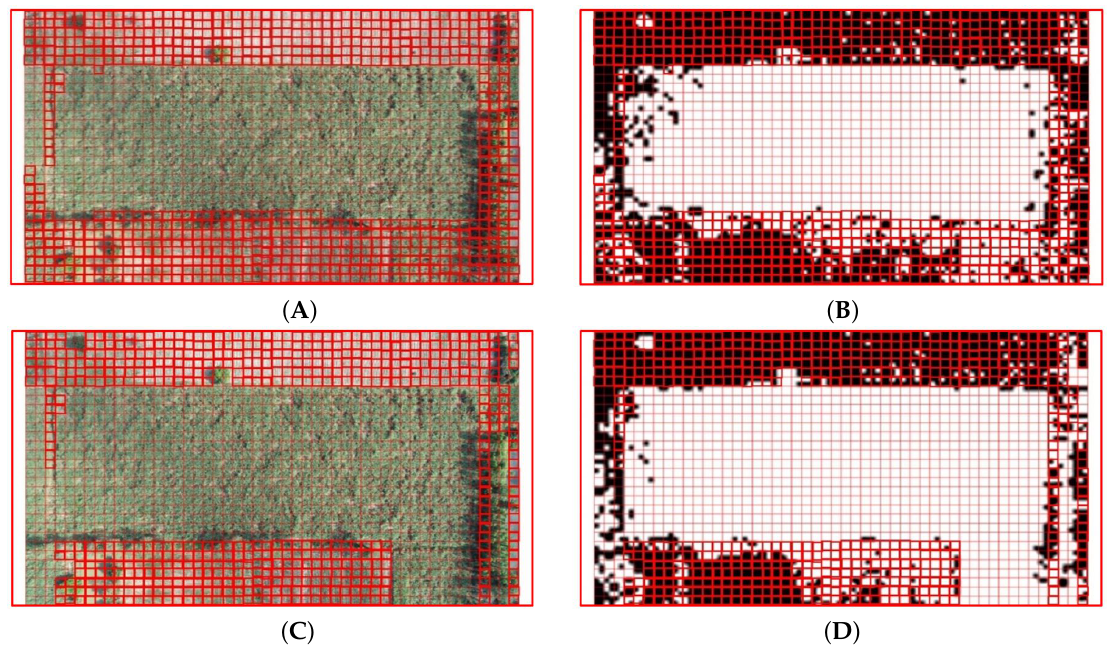
Figure 12. The comparison between experts and the sugarcane area classification model. ( A ) The results from expert of dataset 1, ( B ) the results from model of dataset 1, ( C ) the results from expert of dataset 2, and ( D ) the results from model of dataset 2.